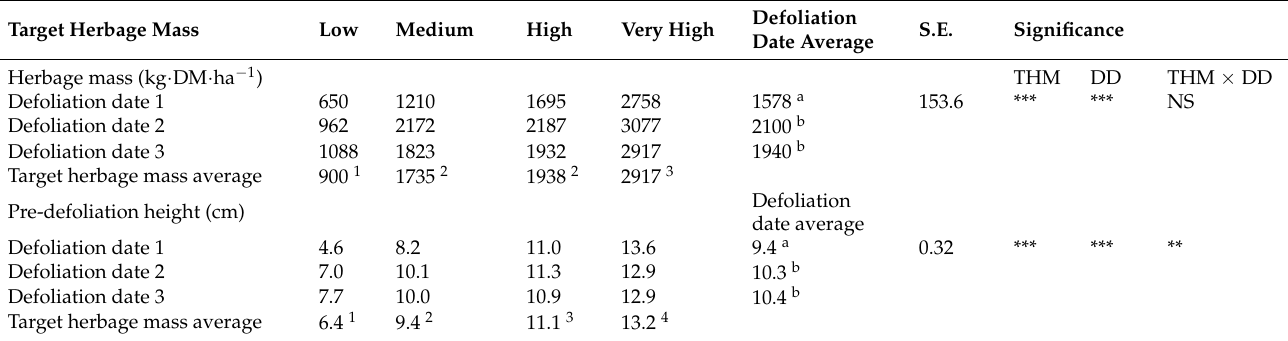
Table 2. Effect of the interaction of target herbage mass (Low—500 kg · DM · ha − 1 , Medium—1500 kg · DM · ha − 1 , High— 2000 kg · DM · ha − 1 and Very high—3000 kg · DM · ha − 1 ) and defoliation dates (DD; DD1—15 October, DD2—7 November and DD3—21 November) at defoliation in autumn on the herbage mass (kg · DM · ha − 1 ) and the pre- grazing sward height